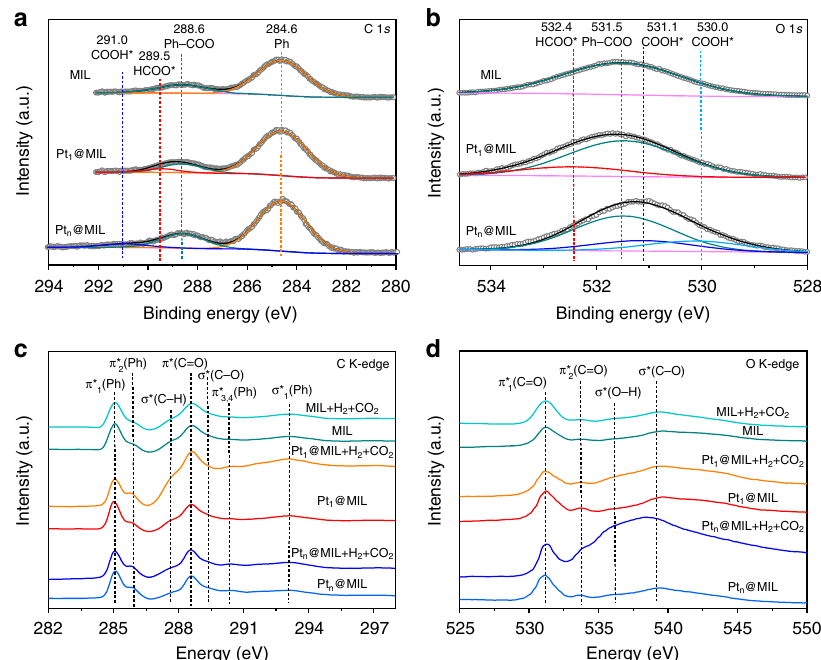
Fig. 4 Mechanistic insight into remarkable activity of Pt 1 @MIL. a , b Quasi-situ XPS spectra of C 1 s and O 1 s for MIL-101, Pt 1 @MIL, and Pt n @MIL after the treatment with H 2 and CO 2 in sequence at 150 °C, respectively. c , d C and O K-edge XANES spectra for MIL-101, Pt 1 @MIL, and Pt n @MIL before/after the treatment with H 2 and CO 2 in sequence at 150 °C,